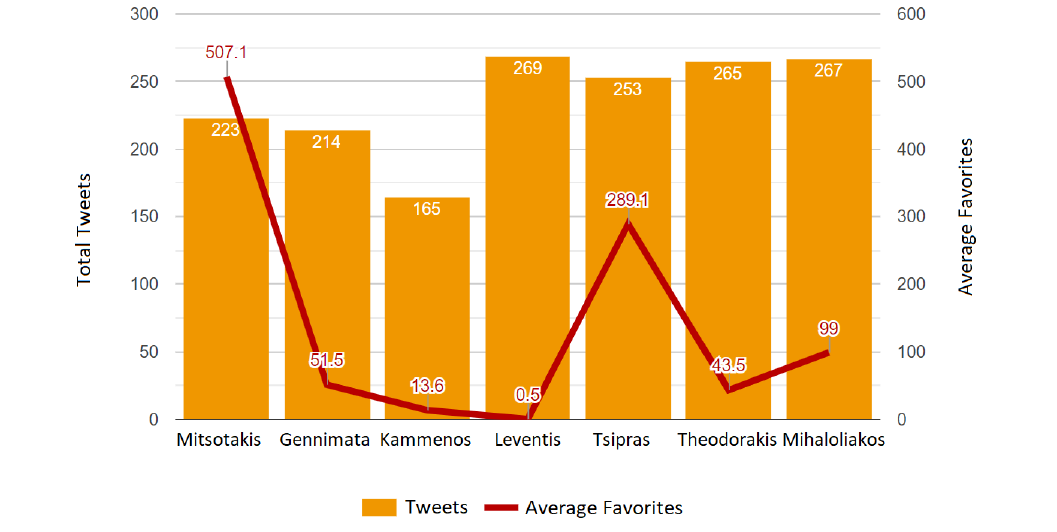
Figure 5. Total tweets and average